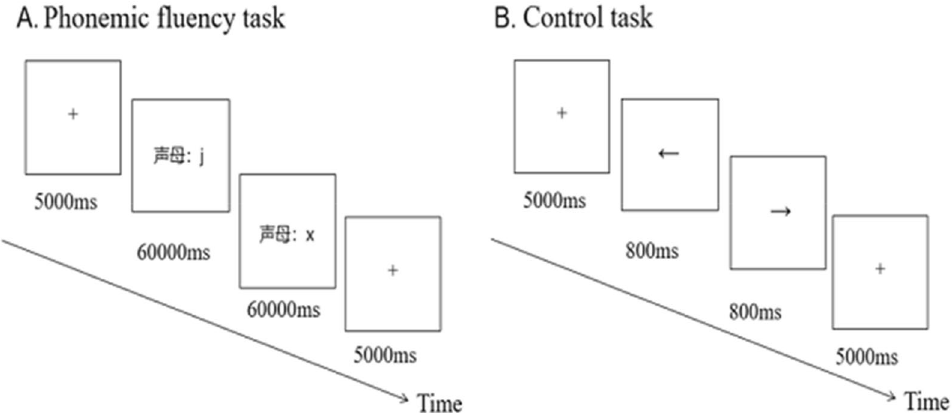
Figure 2. Tasks procedure. ( A ) Phonemic fluency task. In the phonemic fluency task, stimuli were presented visually for 60,000 ms, the words produced by the subjects were recorded via a recording device. ( B ) Control task. Directional arrows were presented visually and subjects had to indicate their direction by pressing the corresponding button.